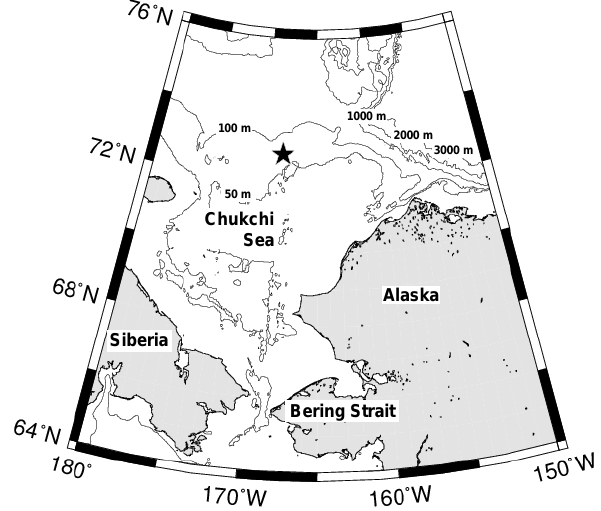
Figure 1. Location of the sampling station in the Chukchi Sea. Depth contours at 50, 100 and 1000m are superimposed.